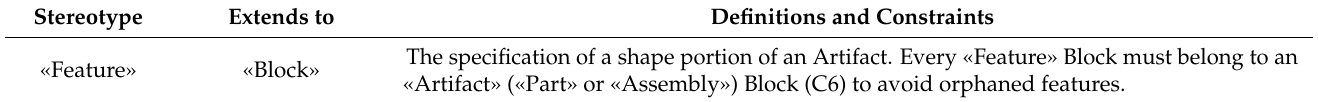
Table A2. Description of main FMPP